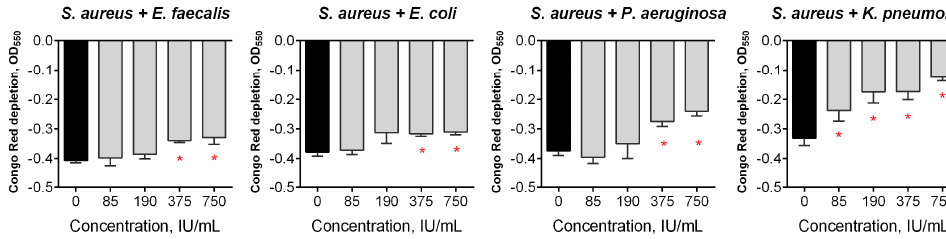
Figure 6. The effect of Longidaza ® treatment on mixed bacterial biofilms. The 48-h old biofilms were gently washed with BM, and a fresh BM broth containing Longidaza ® at concentrations of 85–750 IU/mL was loaded. After 24 h of treatment, the residual biofilms were quantified using a Congo Red depletion assay. The asterisks (*) denote a statistically significant difference of the biofilm in the untreated wells and the wells treated with Longidaza ® ( p < 0.05).